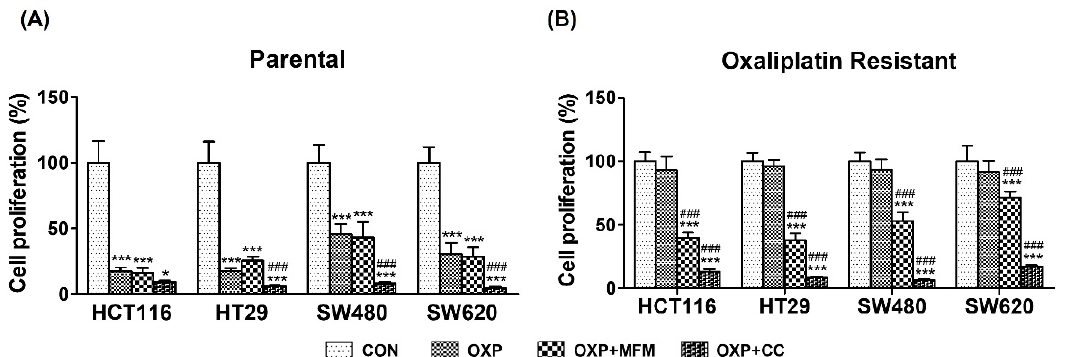
Figure 7. Effects of AMPK on the proliferation of HCT116, HT29, SW480 and SW620 colorectal cancer (CRC) cells by treating metformin as an AMPK activator or compound C as an AMPK inhibitor. ( A ) Parental (PT) CRC cells were pretreated with or without 10 mM metformin and 10 µ M compound C followed by 2.5 µ M oxaliplatin for 72 h. ( B ) Oxaliplatin resistant (OR) CRC cells were pretreated with or without 10 mM metformin and 10 µ M compound C followed by 2.5 µ M oxaliplatin for 72 h. The cell proliferation was determined by an MTT assay. The data are expressed as mean ± standard deviation of triplicate experiments. * p < 0.05; *** or ### , p < 0.001. The * statistics showed only